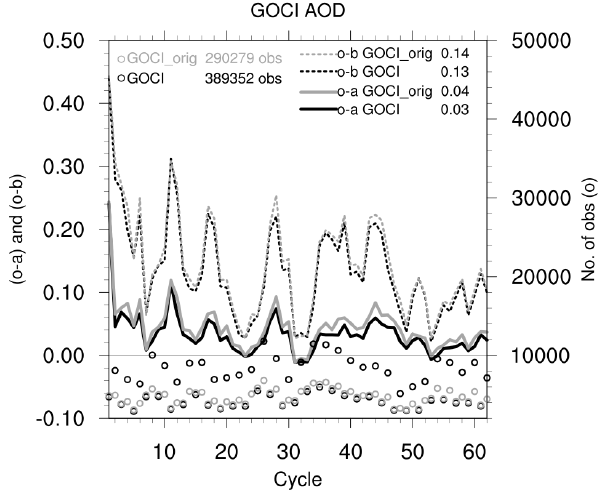
Figure 3. Time series of observation minus analysis (o–a; solid lines) and observation minus background (o–b; dotted) with respect to GOCI AOD retrievals at 550nm for two cycling experiments over domain 1. The GOCI_orig experiment assimilates the original data thinned over the 27km mesh (in gray), while the GOCI experiment assimilates GOCI retrievals averaged over the 27km grid mesh in domain 1 (black). Cycle-mean values are displayed next to each component. The total number of observations assimilated in each experiment at each cycle is also plotted as the “o” sign on the right y axis, ranging from 2000 to 12000.